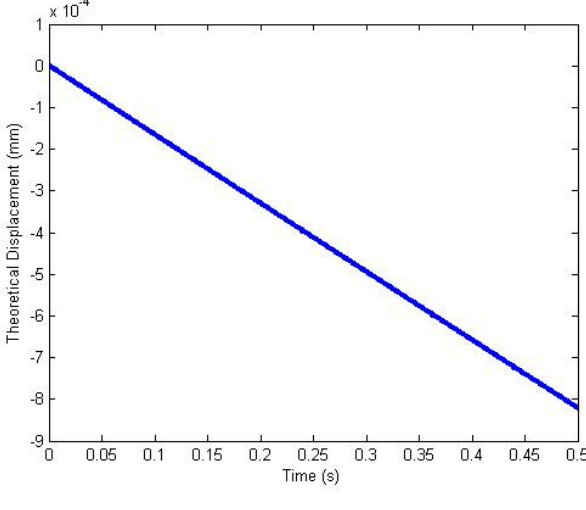
Figure 3. Theoretical deflection of IPMC with time (step